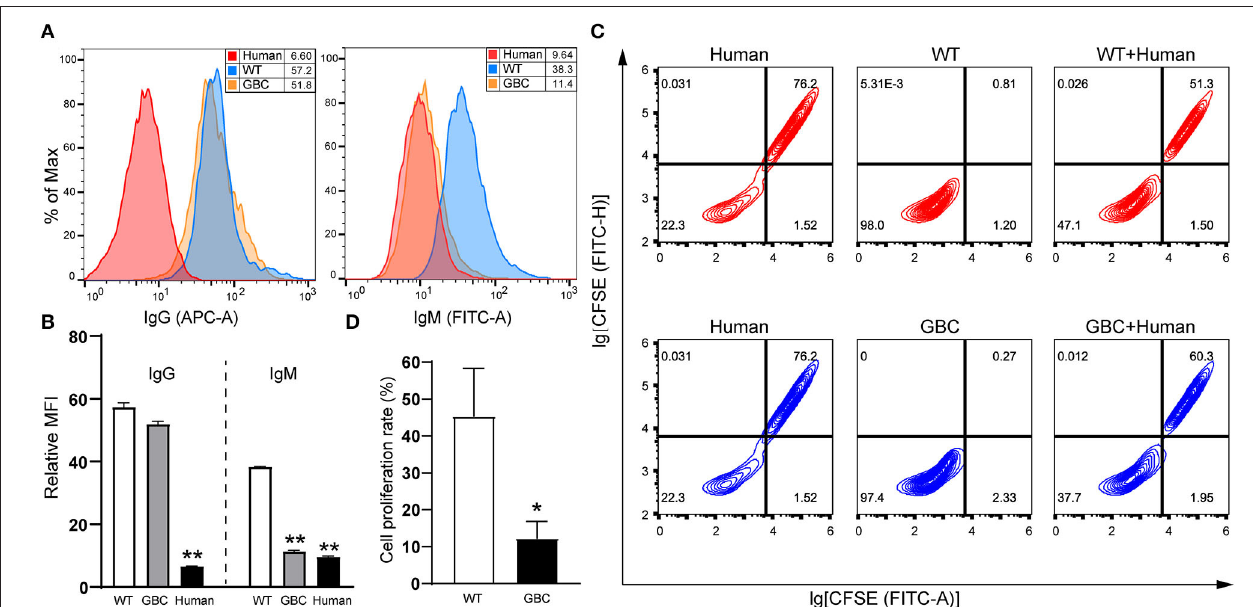
FIGURE 7 | Evaluation of anti-immunological rejection effectiveness of GBC-modified pigs. (A) Reduction of human IgM binding to GBC-modified pig fibroblast cells. (B) Relative mean immunofluorescence intensity (MFI) of IgG and IgM antibodies binding to WT, GBC-modified, and human fibroblast cells treated with mixed human serum. Data of three dependent experiments are presented (** P < 0.01 vs. WT). (C) Proliferation analysis of human peripheral blood mononuclear cells (PBMCs) after stimulation with porcine PBMCs by flow cytometry, and human PBMCs were labeled with CFSE. (D) Quantification of the proliferation rate of human PBMCs stimulated with porcine PBMCs (* P < 0.05 vs.